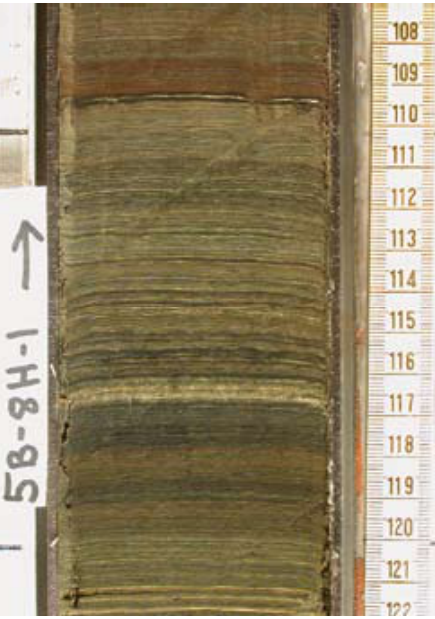
Figure 8. Laminated (and most likely varved) lake sediments from Bosumtwi